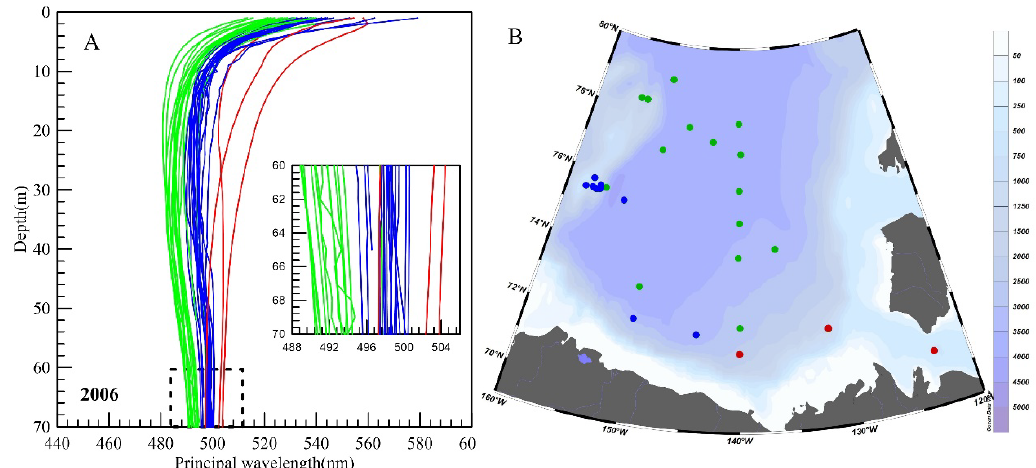
Figure 3. ( A ) The profiles of the principal wavelength recorded in the Canada Basin. The stations and accompanying profiles in (B) are indicated with red, blue, and green dots according to the classification of K d (coastal type, inflow-influence type, and basin type). The subgraph in ( A ) enlarges the profiles of the principal wavelength at depths of 60–70 m.